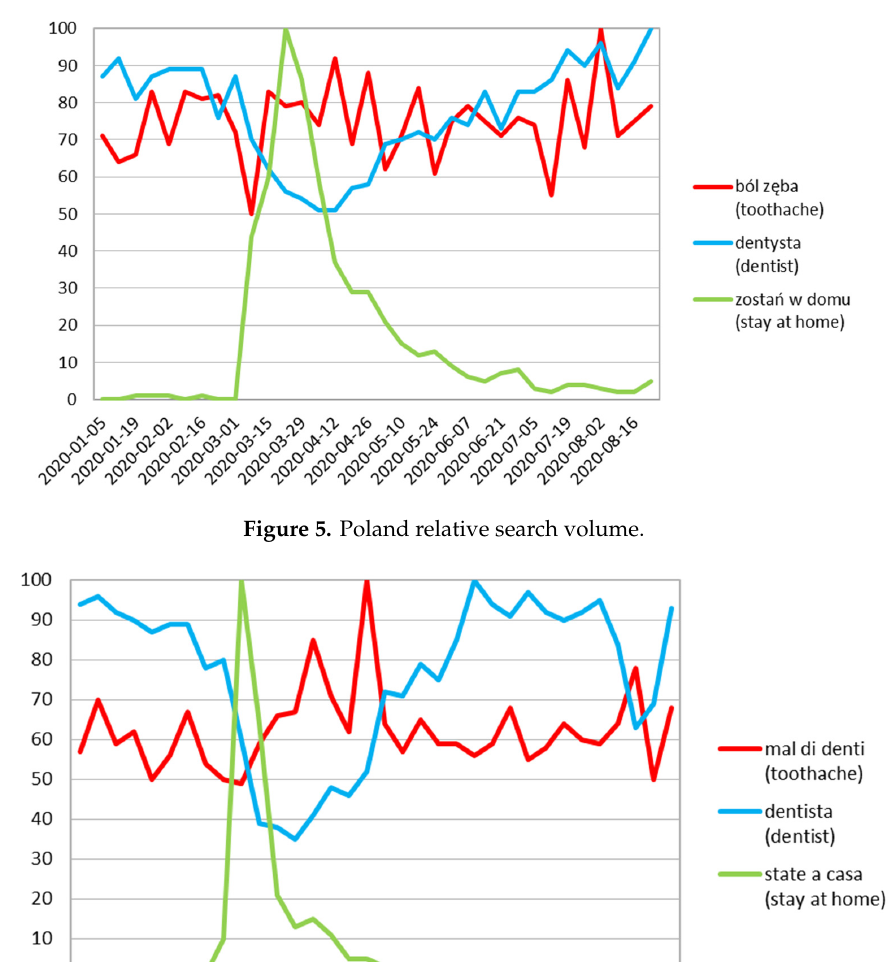
Figure 6. Italy relative search volume.